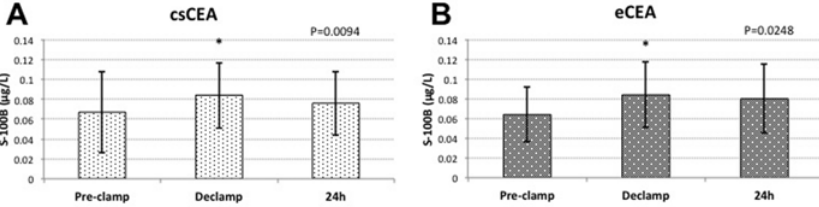
Fig 2. Variations of protein S-100B serum concentrations within groups. (A) csCEA group; (B) eCEA group; * — significant compared to pre-clamp (P <